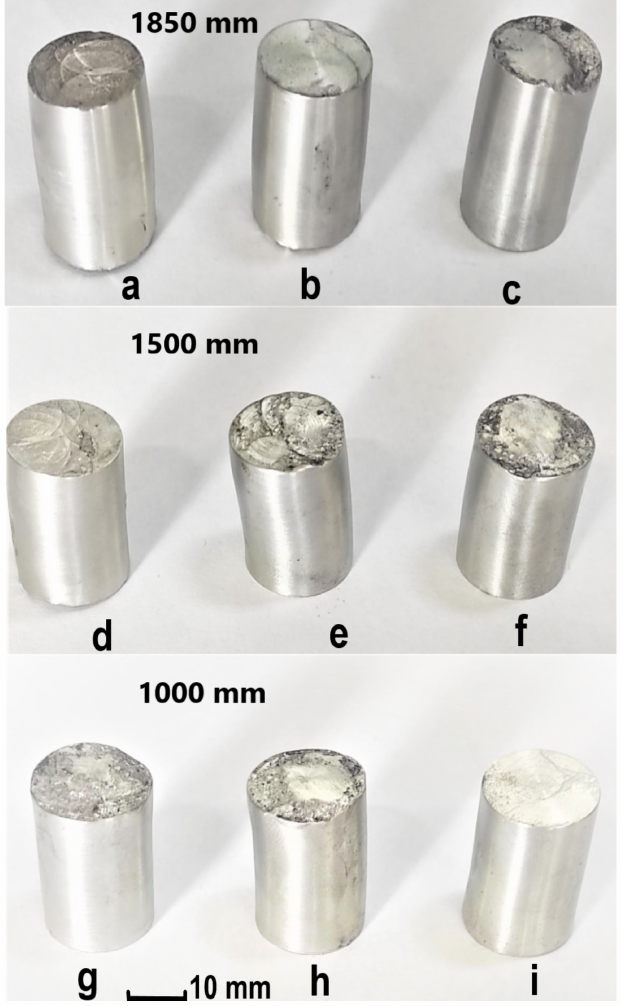
Figure 10. Cylindrical samples deformed on hammer from a ram drop height of 1850 mm ( a – c ), 1500 mm ( d – f ), and 1000 mm ( g – i ) for different friction conditions: ( a , d , g ) dry; ( b , e , h ) mineral oil; ( c , f , i ) graphite in